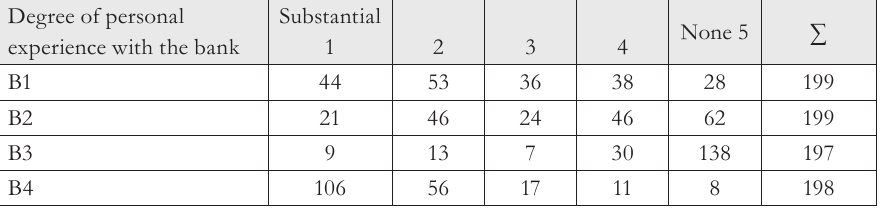
Tab. 1 - Profile of the sample of respondents according to the degree of their personal experience with individual banks. Source: